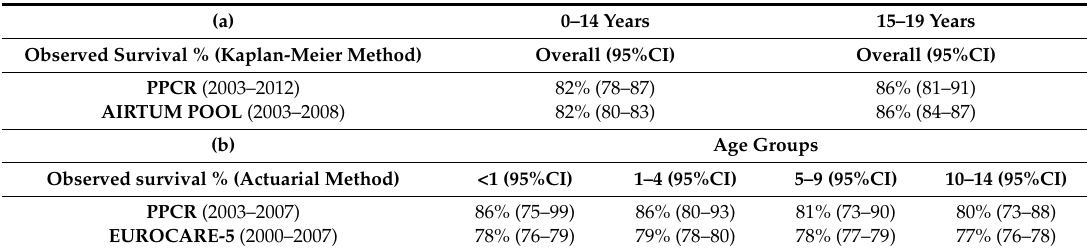
Table 3. Comparison of five-year observed survival (%) and its 95%CI for “malignant tumours”: